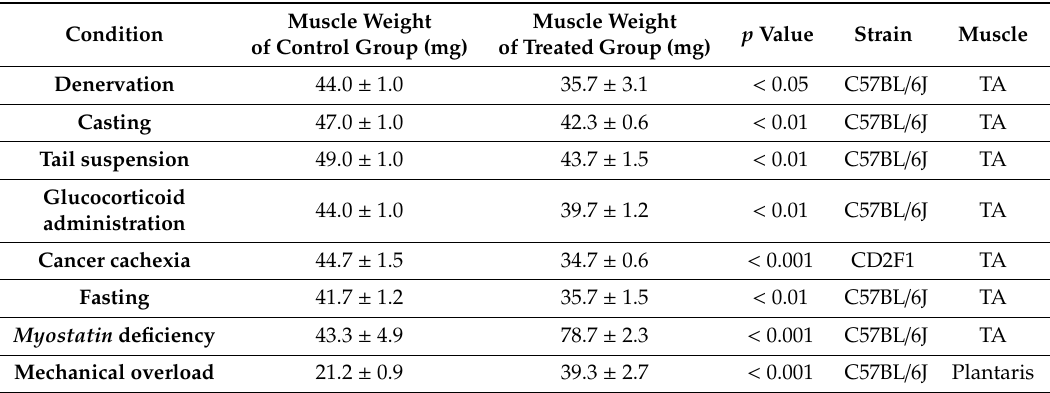
Table 1. Muscle weight changes in each